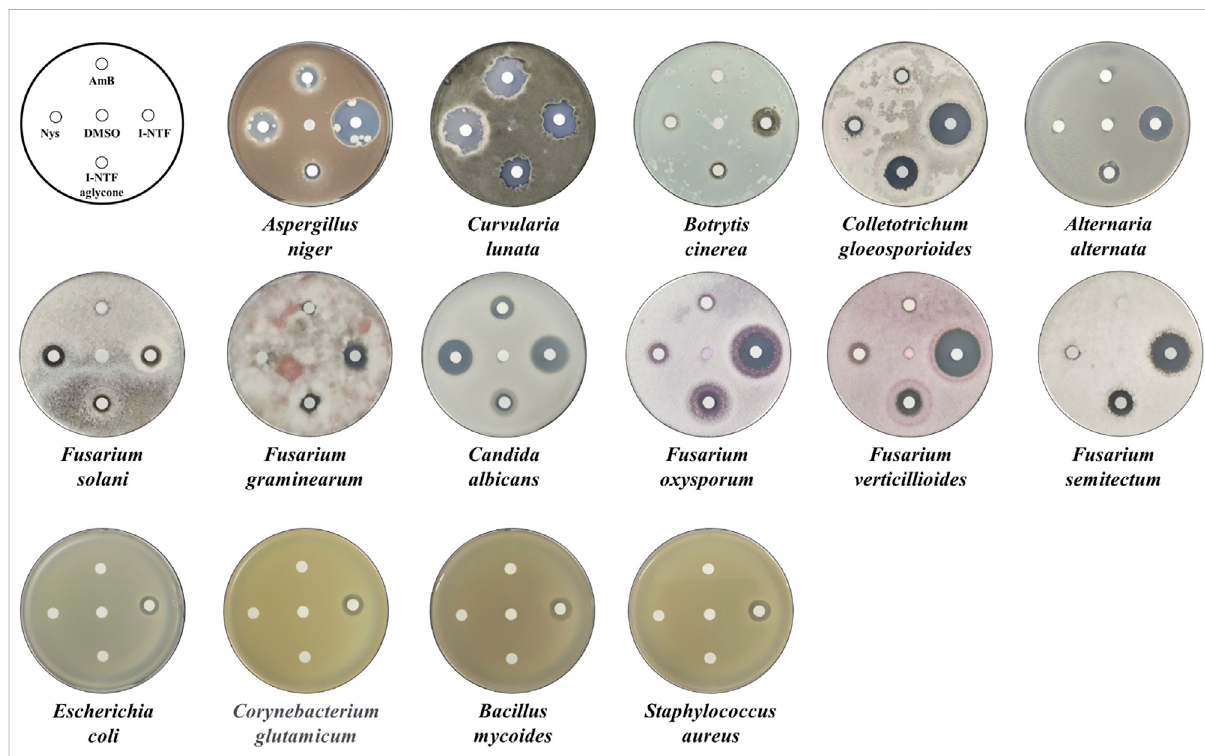
FIGURE 4 Antifungal and antibacterial assay. Comparison of the antifungal activity against 11 fungi and antibacterial activity against four bacteria. 10 μ g of each polyene was loaded on a paper disc and placed on each plate. 3 days passed after being placed on the PDA plate containing fungus and 1 day passed after being placed on the NA plate medium containing bacteria. AmB, amphotericin B; Nys, nystatin A1; DMSO, dimethyl sulfoxide (Negative control).